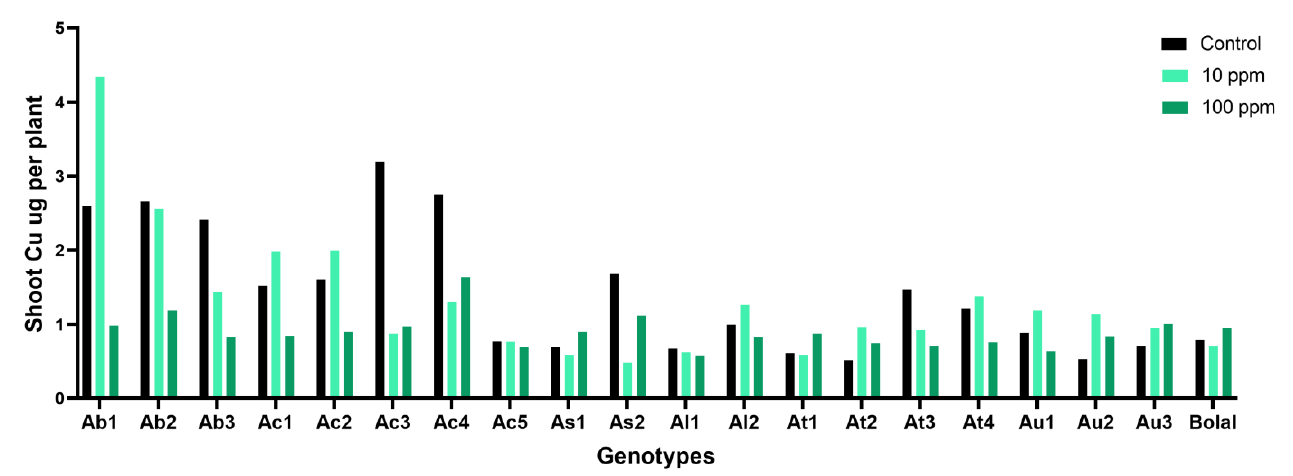
Figure 6. Variation in the RCu (root copper) uptake and SCu (shoot copper) uptake of 19 Aegilops genotypes and Bolal 2973, the B tolerant check genotype in Control (3.1 μM B), 10 ppm B (toxic B), and 100 ppm B (highly toxic B).